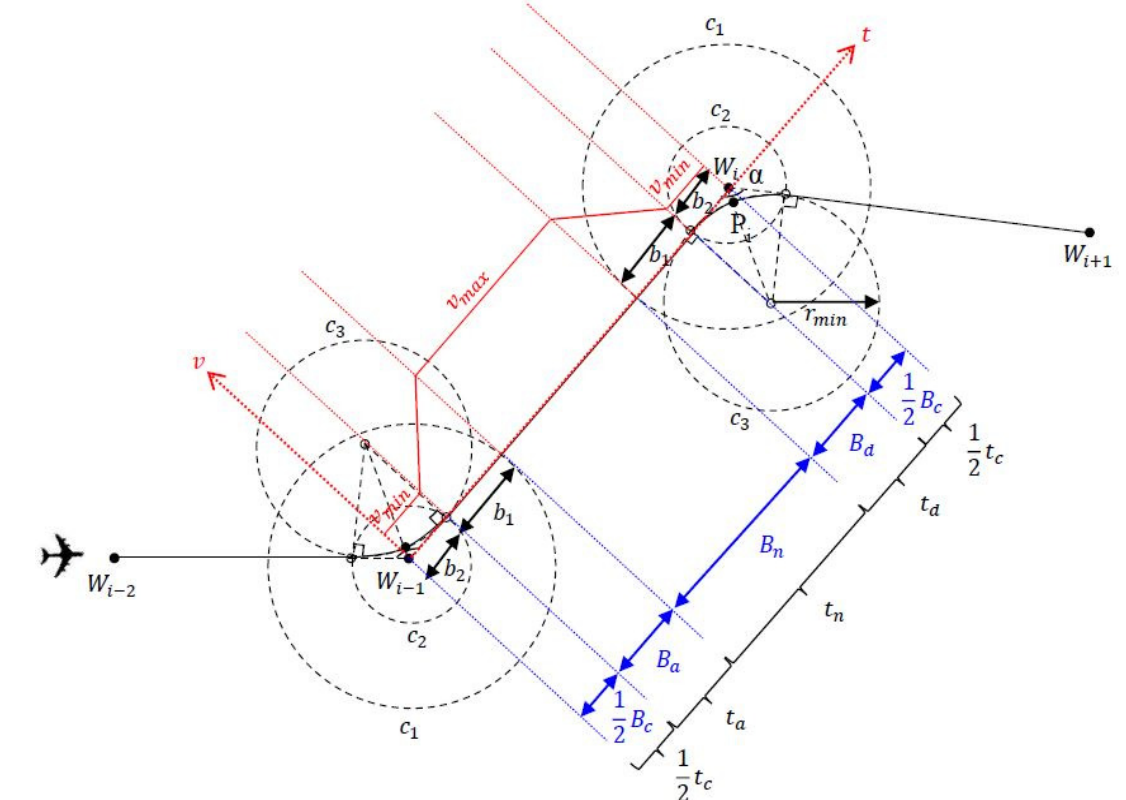
Figure 4. Analysis of flight path using the Dubins path method [18–20].